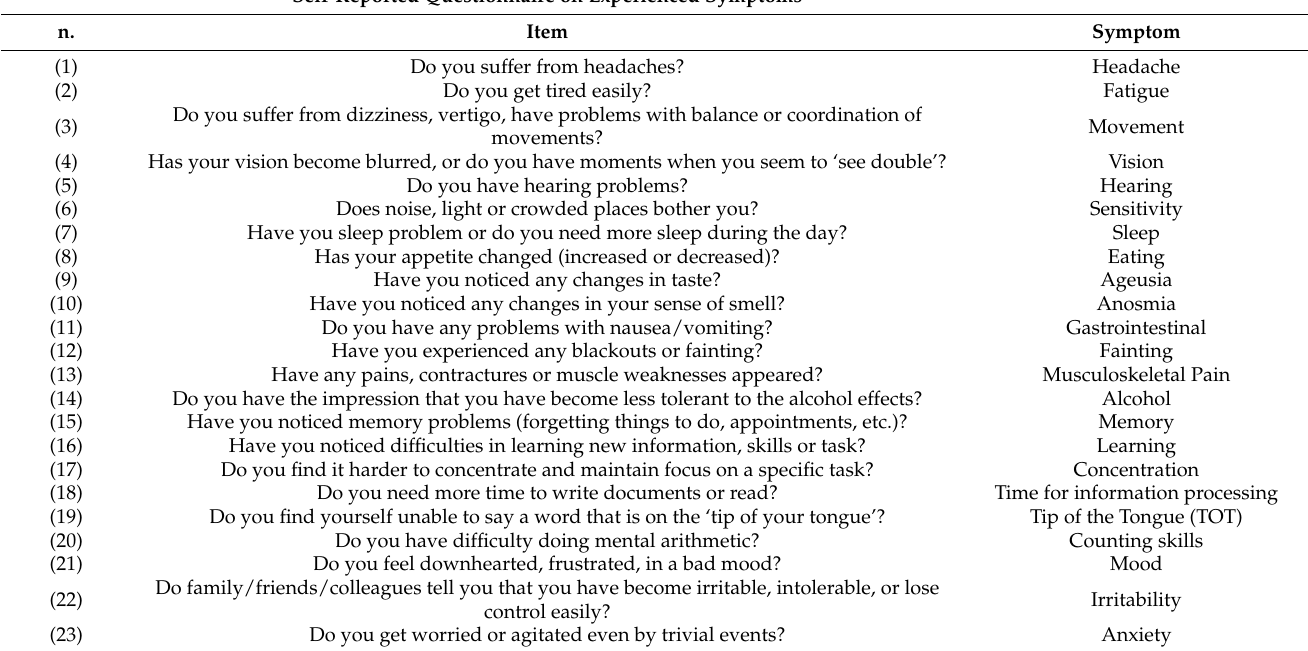
Table 3. Items included in the administered questionnaire. Item of the administered questionnaire. The “symptom” column shows the symptom measured by the related